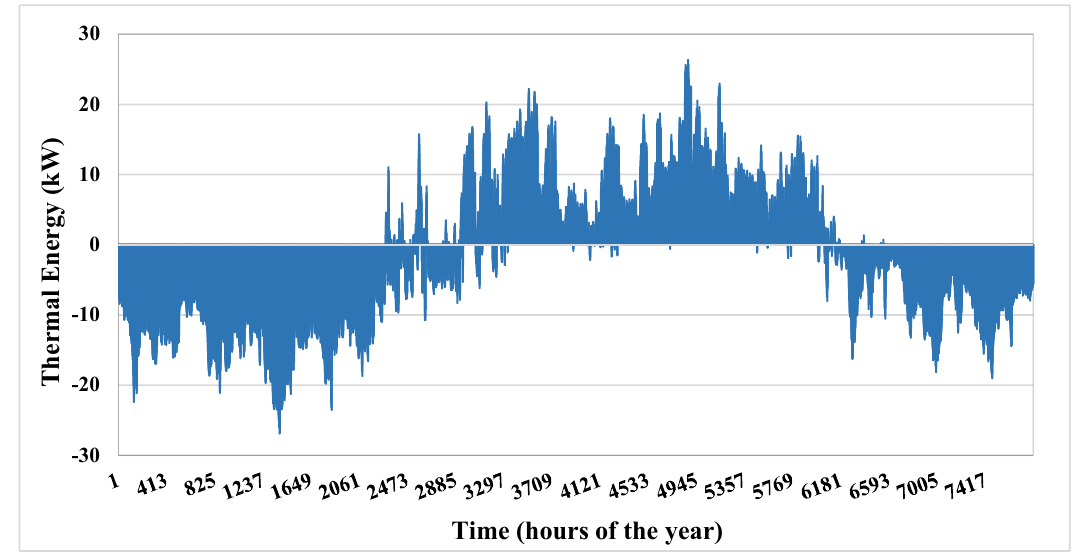
Figure 13. Rate of cold lost to the environment during the year. Table 5. The total annual statistics of the system key operation. As can be seen, although the total excess heat (due to 5026 tonnes of excess MSW) of the case study is about 17 GWh over the cooling season, the proposed district cooling system with 50